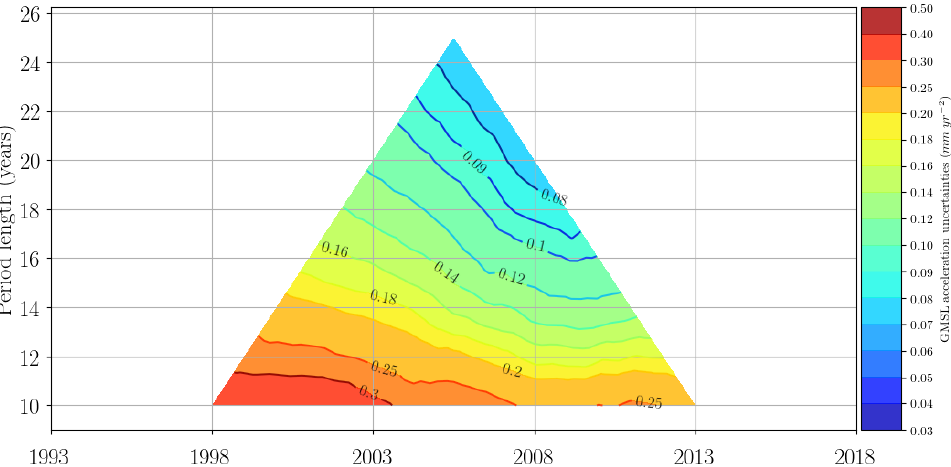
Figure 6. GMSL acceleration uncertainties (mmyr − 2 ) estimated for all the altimeter periods within the 25-year period (January 1993 to December 2017). The confidence level is 90% (1 . 65 σ ). Each colored pixel represents, respectively, the half-size of a 90% confidence range in the GMSL acceleration. Values are given in mmyr − 2 . The vertical axis indicates the length of the period (ranging from 1 to 25 years) considered in the computation of the acceleration, while the horizontal axis indicates the center date of the period (for example, 2000 for the 20-year period